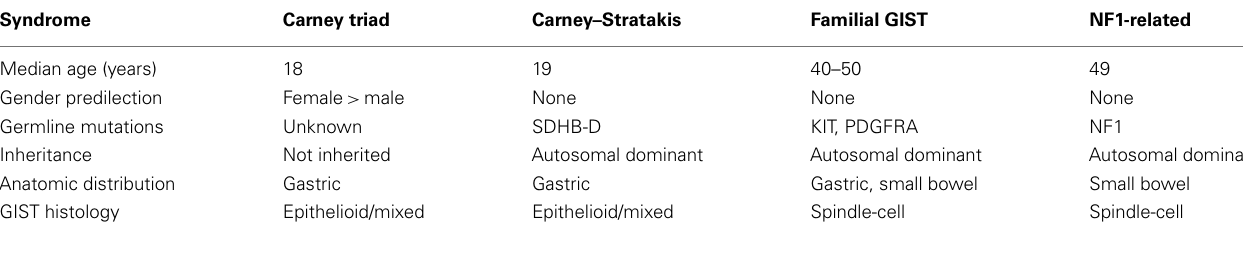
Table 1 | Characteristics of syndromic